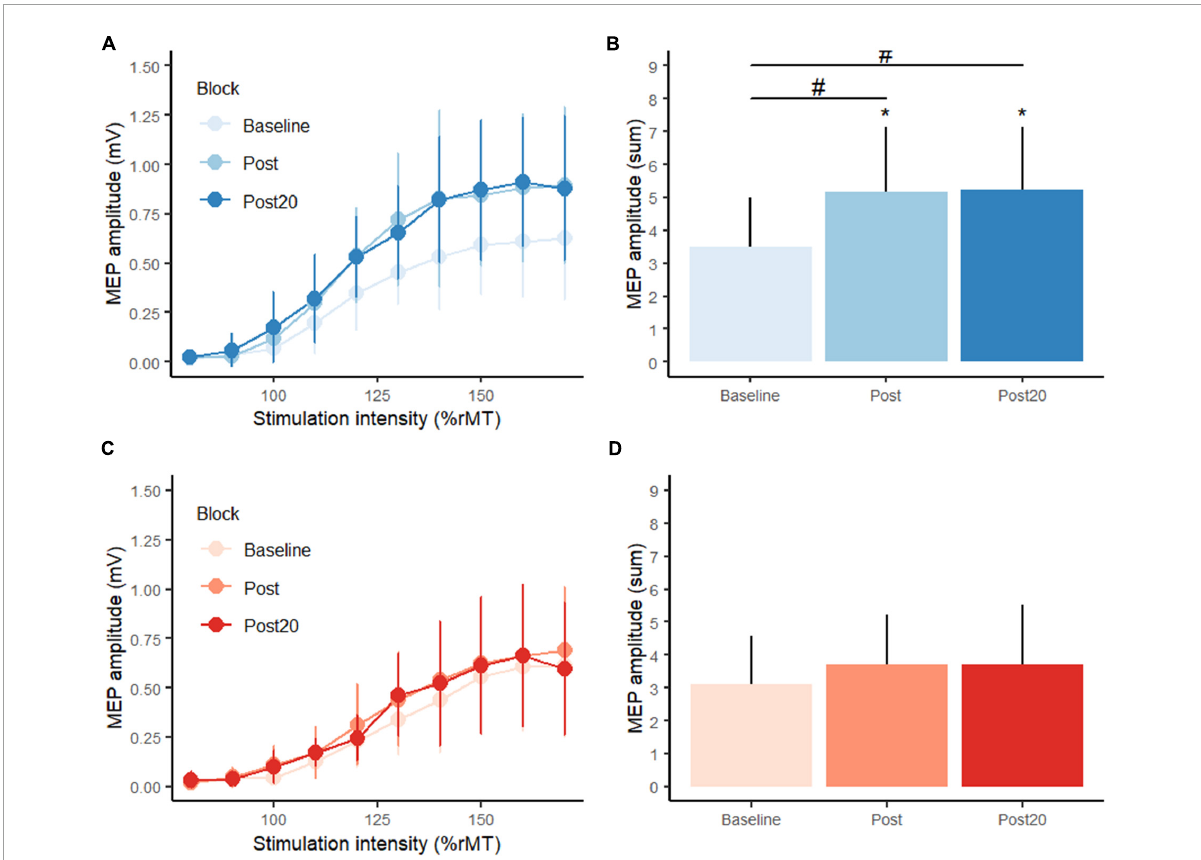
FIGURE4 Transcranial magnetic stimulation (TMS) stimulus-response curves from (A) the position control practice group (blue colors), (C) the force control practice group (red colors) at baseline, post practice and 20 min post practice from the supplementary experiment. Panels (B,D) display summed motor evoked potential amplitudes (MEP) at baseline, post practice and 20 min post practice. *Denotes a significant difference within group and # denotes significant difference between